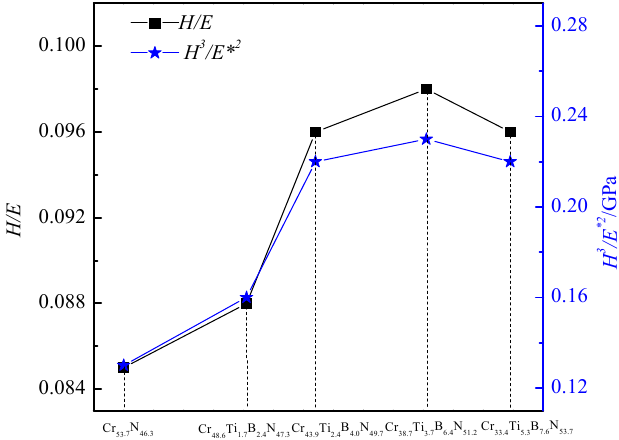
Figure 5. Calculated H / E and H 3 / E * 2 values of Cr ‐ Ti ‐ B ‐ N films.